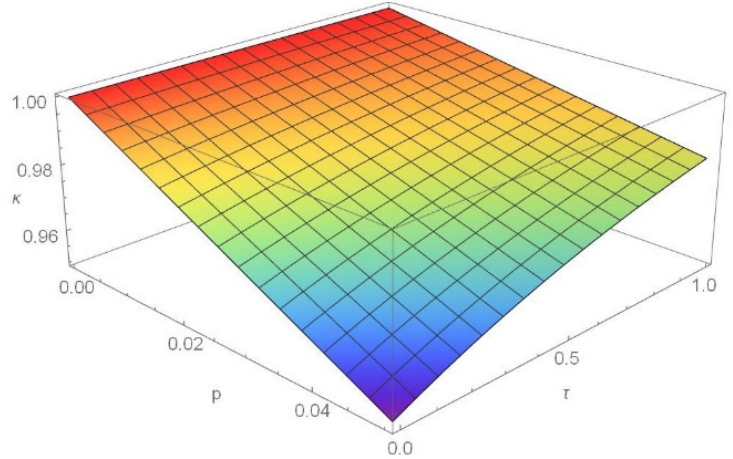
Figure 3. Stiffness coefficient κ as function of slow time τ and parameter p .